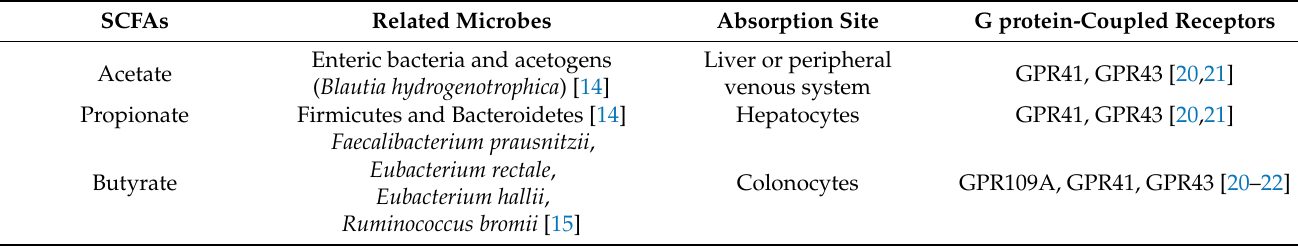
Table 2. The production, absorption, and transport receptors of major